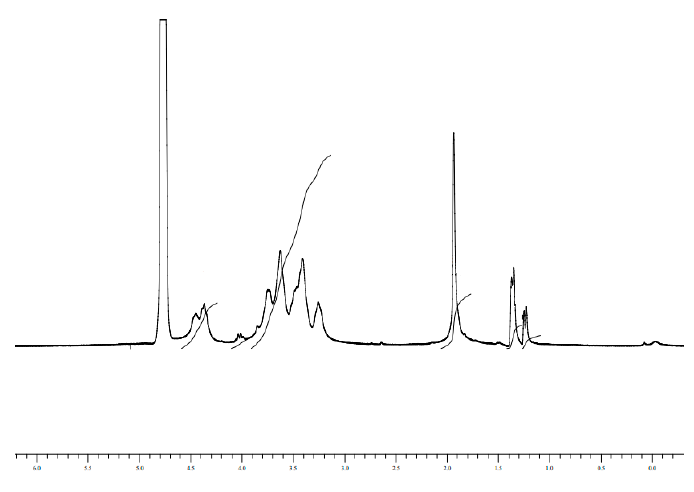
Figure 7. NMR spectrum of sample T7F1 in D2O.